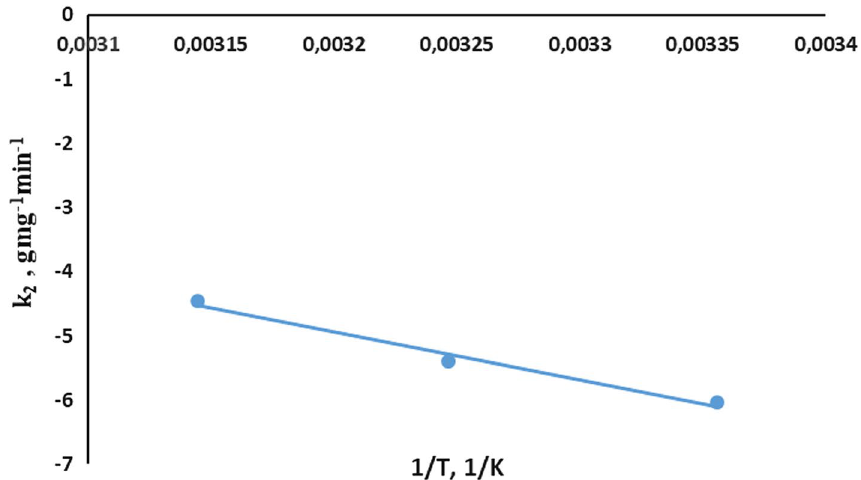
Fig. 8 The Arrhenius plot for the biosorption